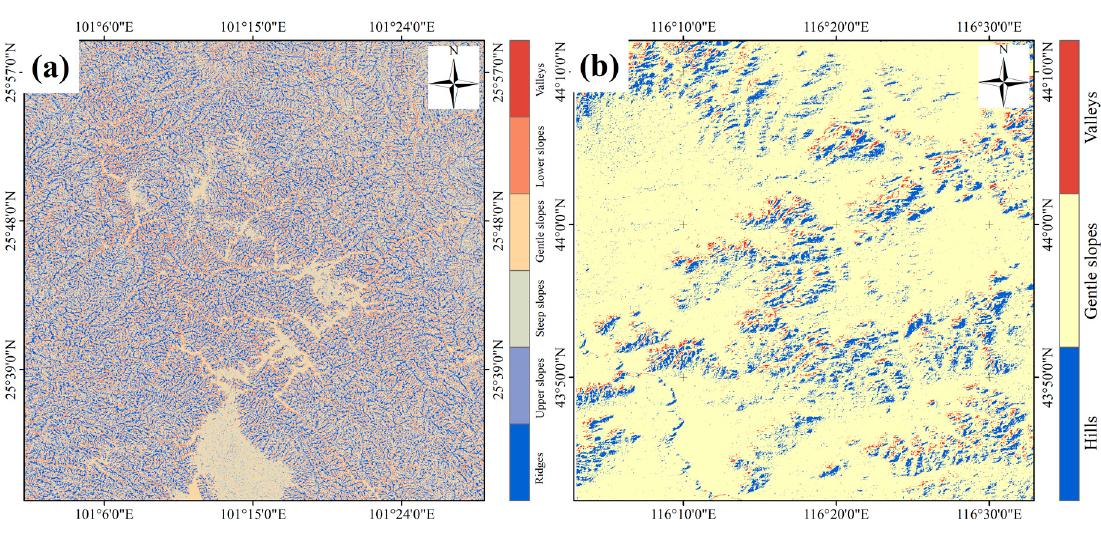
Figure 10. Relationship between the DEM N elevation error and slope and aspect.